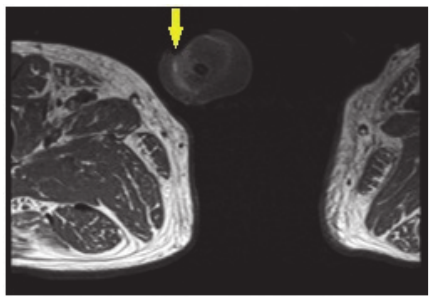
Figure 3: MRI pelvis showing T1 hyperintensity surrounding the glans penis, consistent with necrosis of the tip of the glans penis.